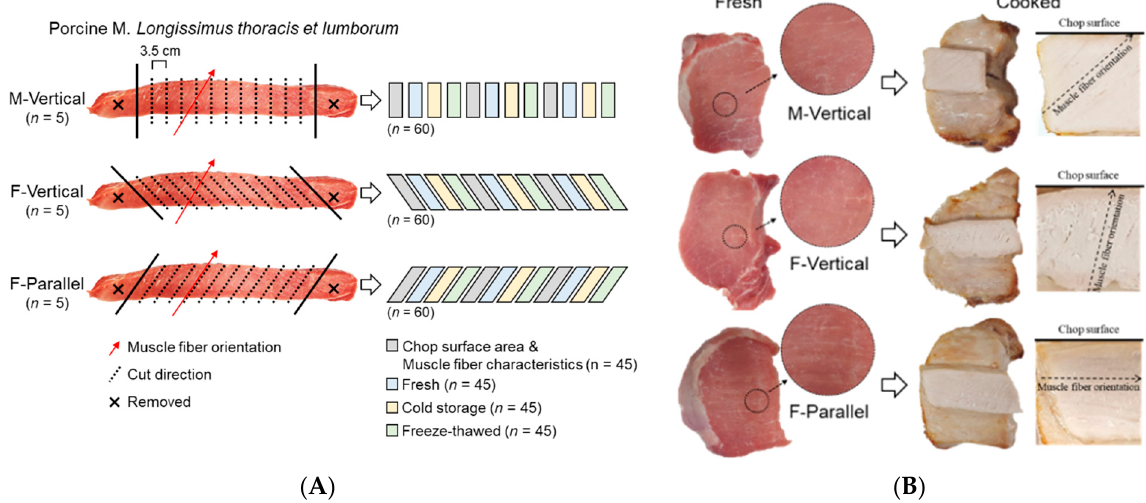
Figure 1. Schematic representation of pork loin (M. longissimus thoracis et lumborum ) chop preparation. ( A ) Preparation method of pork loin chops cut in different directions: M-Vertical, cut vertical to the longitudinal direction of loin muscle; F-Vertical, cut vertical to the muscle fiber orientation; F-Parallel, cut parallel to the muscle fiber orientation. Fresh, at 1 day postmortem stored at 1 °C; Cold storage, stored at 1 °C for 7 days; freeze–thawed, frozen at − 20 °C for 5 days and thawed at 1 °C for 2 days. ( B ) Representative images of fresh and cooked pork loin chops cut in different directions.